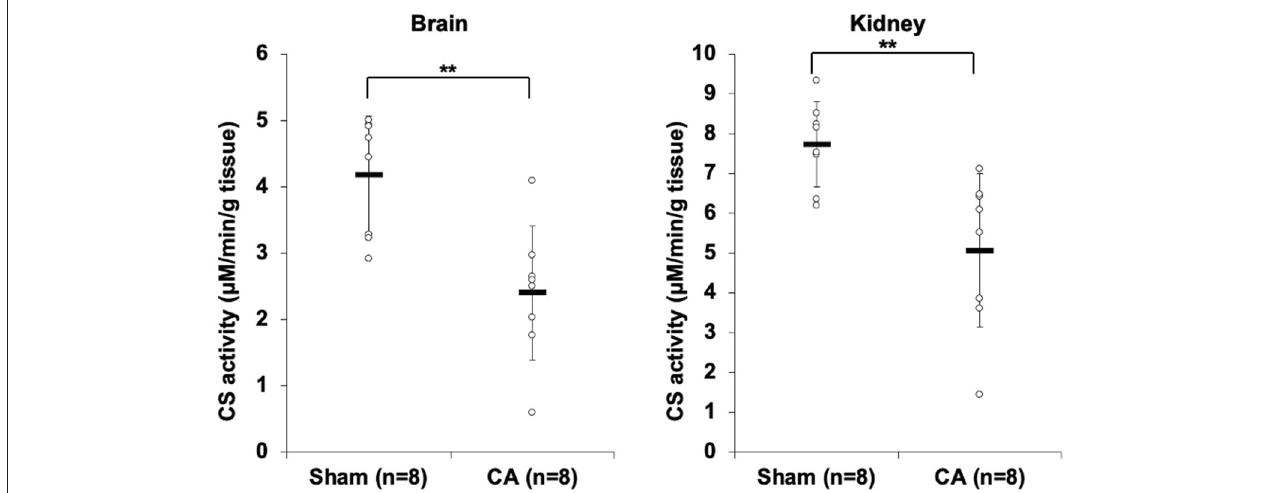
FIGURE 1 | Results of citrate synthase activity assay comparing isolated mitochondria of cardiac arrest rats with that of sham rats. The CS activity of the brain and kidney mitochondria in the CA group declined significantly compared to that in the sham group (brain, 2.40 ± 1.01 and 4.19 ± 0.89 µ mol/min/g tissue, p < 0.01; kidney, 5.07 ± 1.92 and 7.73 ± 1.07 µ mol/min/g tissue, p < 0.01, respectively). ** p < 0.01.